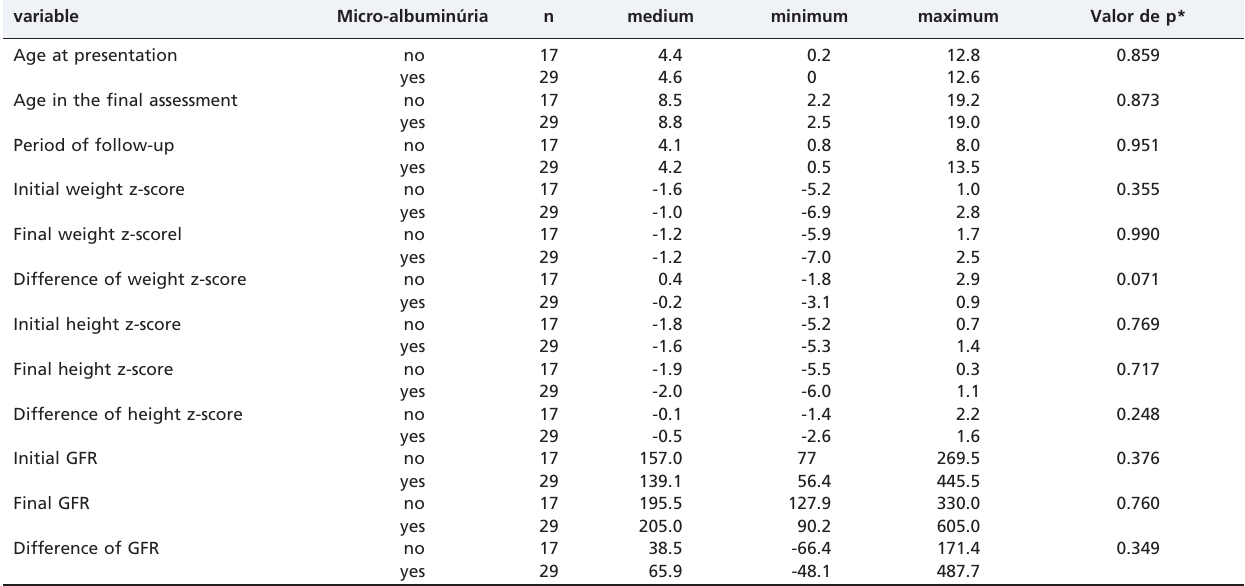
Table 5 - Comparison between the group without microalbuminuria and the group with microalbuminu´ ria regarding to age at presentation, age in the final assessment, period of follow-up, initial/final weight z-score, difference of weight z- score, initial/final height z-score, difference of height z-score, initial/final GFR, and difference of